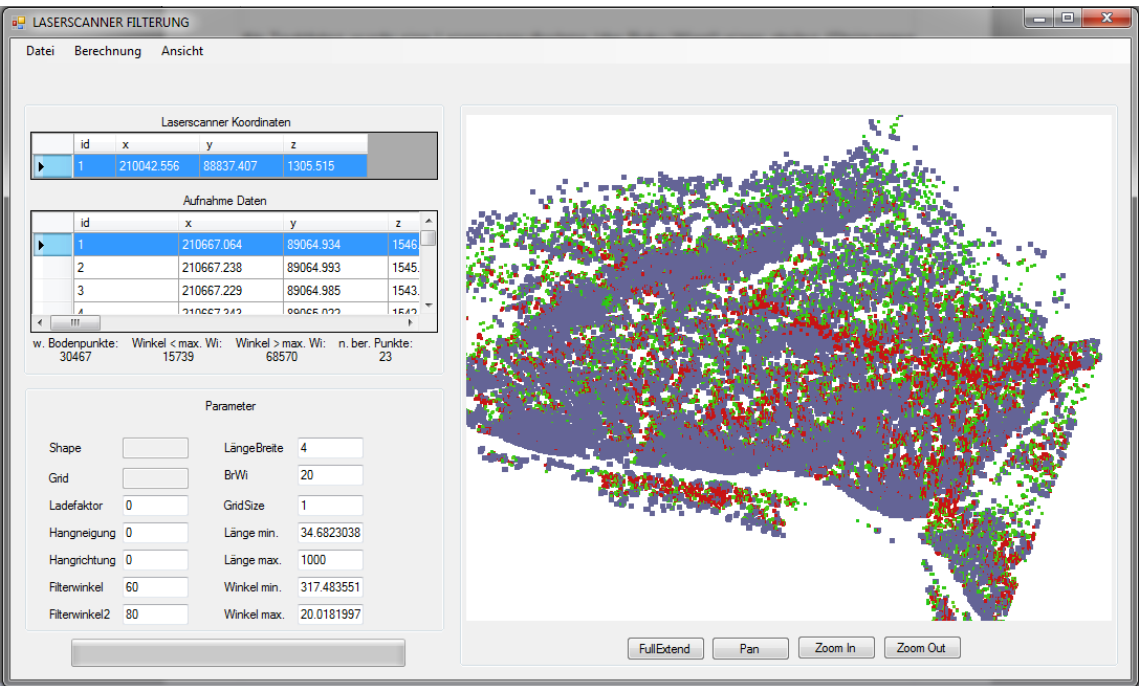
Figure 9. Screenshot of the calculation using our own computer